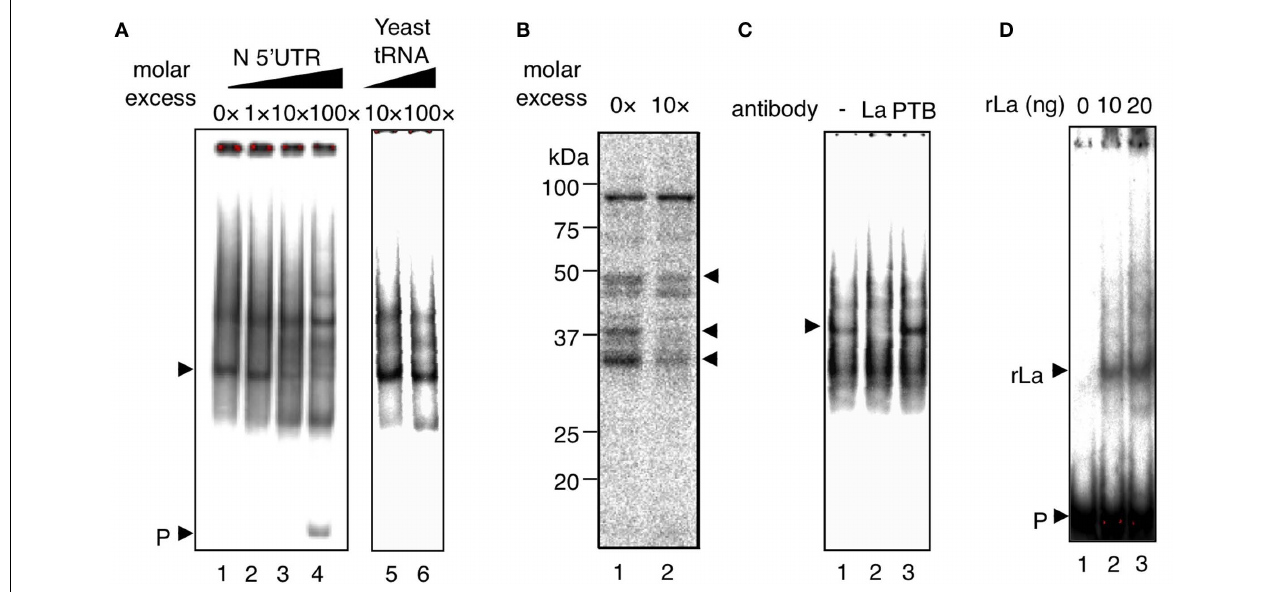
competitor RNA, lane 2) was approximately 35, 40, or 50kDa (indicated by arrows). (C) The antibody against La inhibited the interaction of N-5 (cid:2) UTR and specific-binding protein (arrow; lane 2). As a control experiment, antibody against PTB was added (lane 3). (D) Recombinant La binds to the N-5 (cid:2) UTR probe.The probe (P) without rLa is shown in lane 1. rLa at the indicated dose was added to the reaction (lanes 2 and 3).The arrow indicates the complex derived from the rLa-probe.